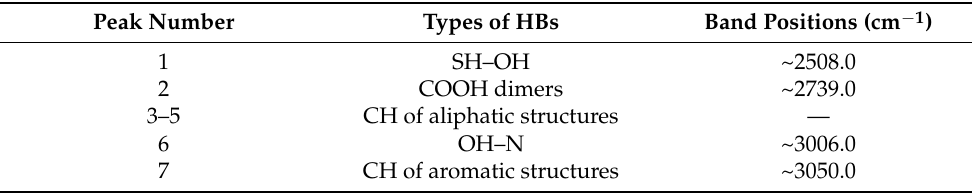
Figure 4. Curve fitting of the FTIR spectrum ranging from 2400 cm − 1 to 3600 cm − 1 . (Assignment of sub-peaks (1 − 11) can be found in Table 3). Table 3. Assignment of the FTIR spectrum in the range of 2400–3600 cm − 1 (According to Painter et